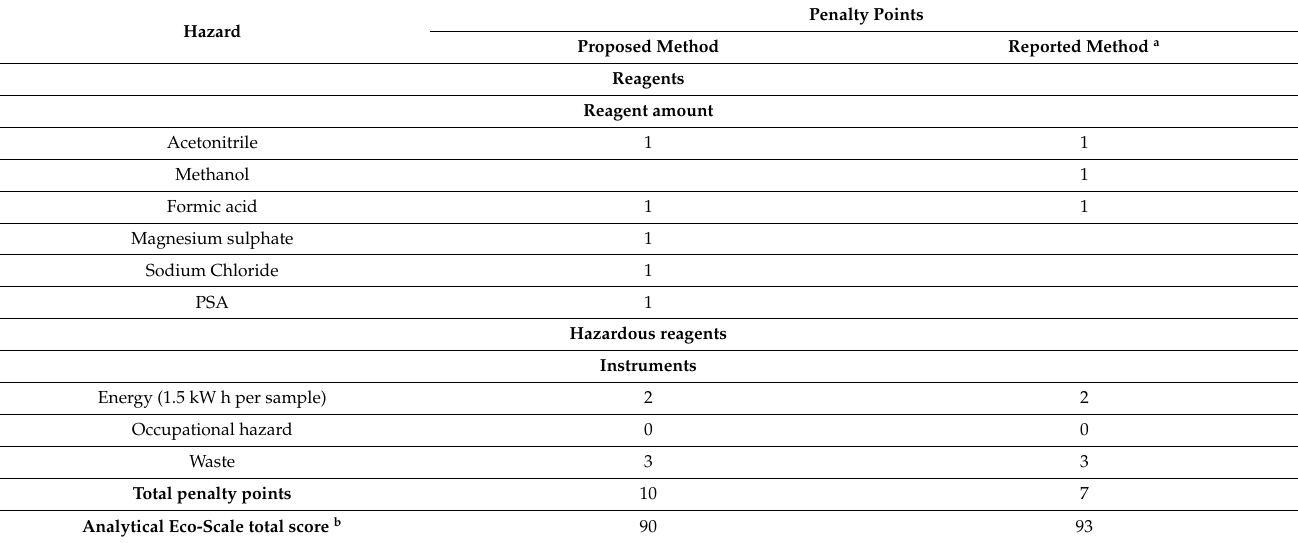
Table 6. Penalty points for the greenness assessment of the proposed chromatographic method as compared with the reported method.